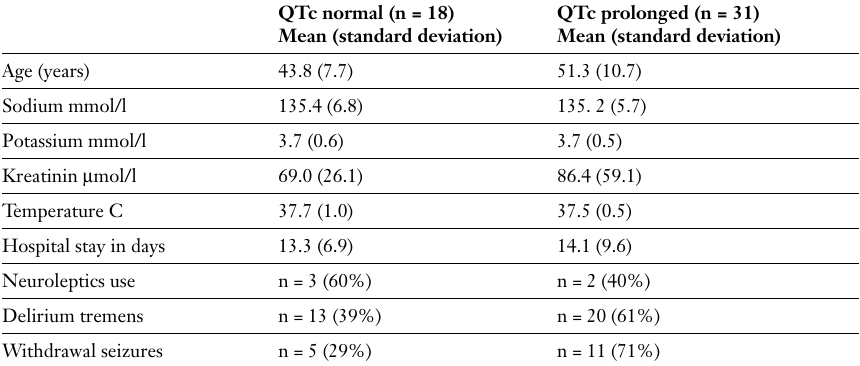
Table 2 Comparison of clini- cal and laboratory parameters between subjects with normal and prolonged QTc values.